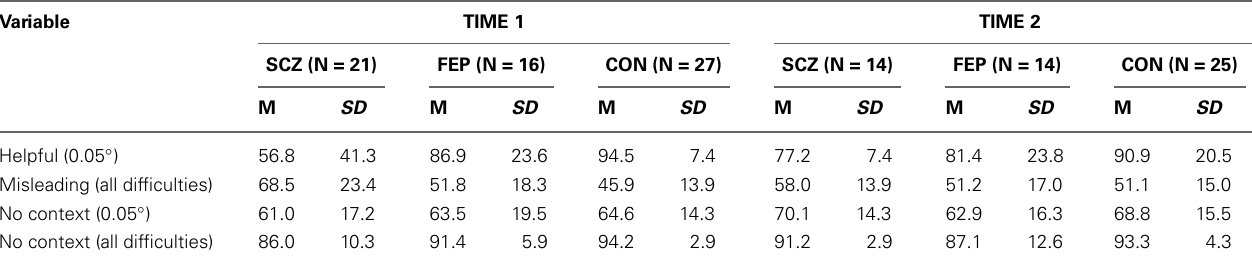
Table 2 | Percent correct in each condition in the Ebbinghaus illusion task, by group, at each time point.